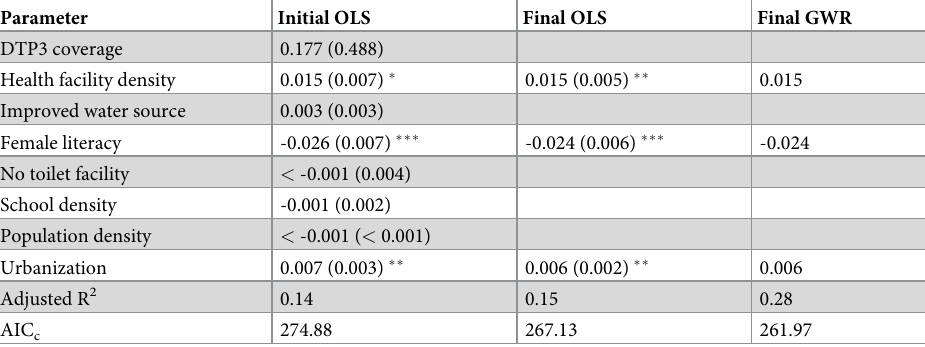
Table 3. Summary of the OLS a and GWR b models. Parameter Initial OLS Final OLS Final GWR DTP3 coverage